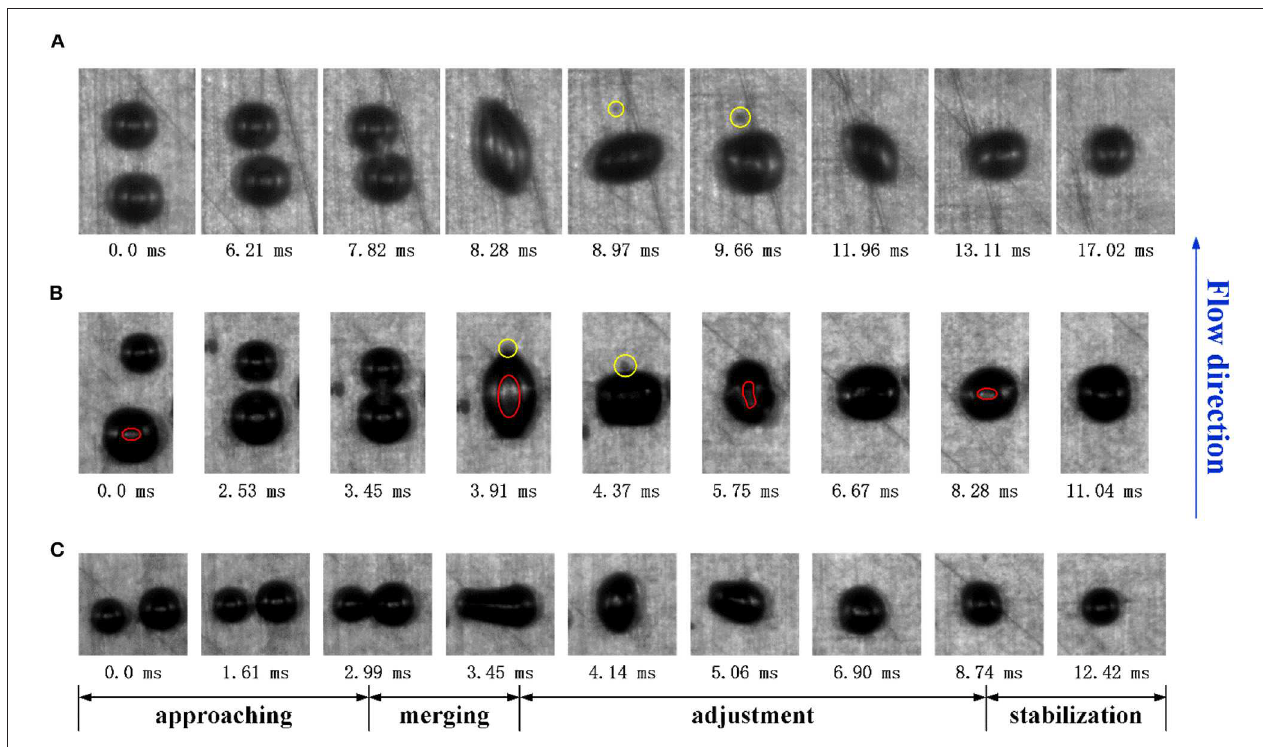
FIGURE 2 | Bubble coalescence image. (A) q = 114.3 kW · m − 2 ; 1 T sub,in = 31 ◦ C; G = 333.9 kg · m − 2 · s − 1 , (B) q = 212.2 kW · m − 2 ; 1 T sub,in = 30.8 ◦ C; G =